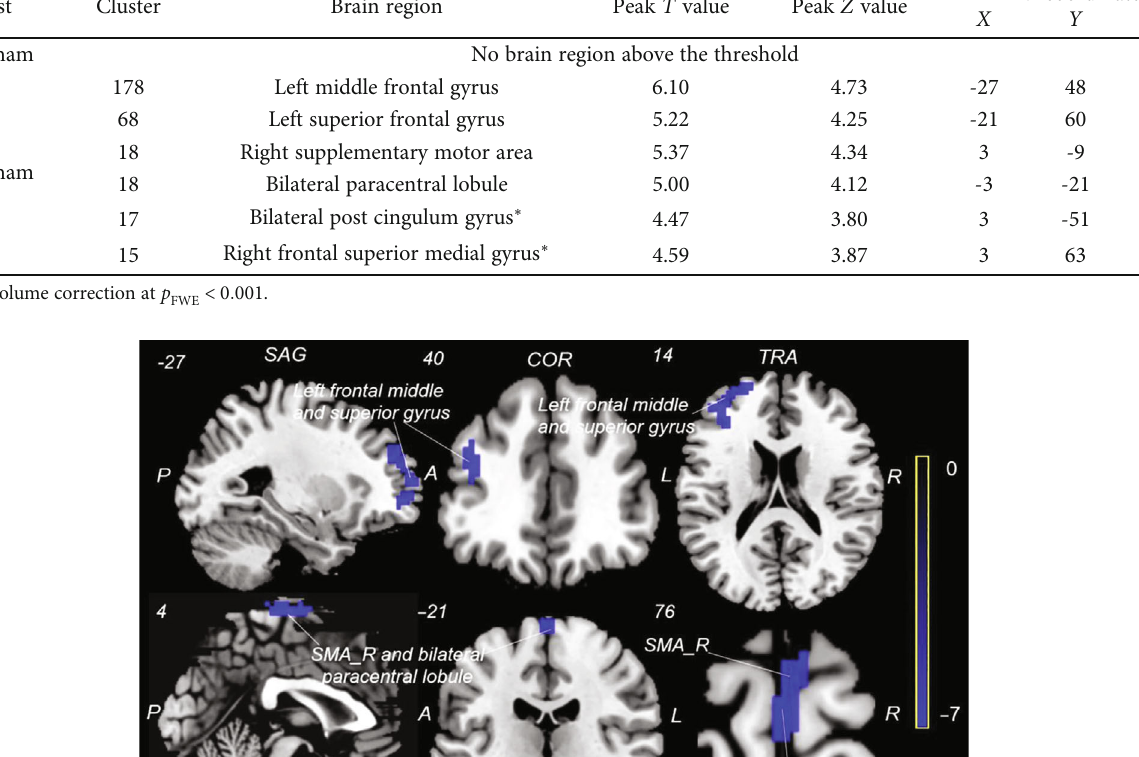
Table 2: The functional connectivity results using the left amygdala as a seed in 27 MwoA patients. Contrast Cluster Brain region Peak T value Peak Z value Real > sham No brain region above the threshold